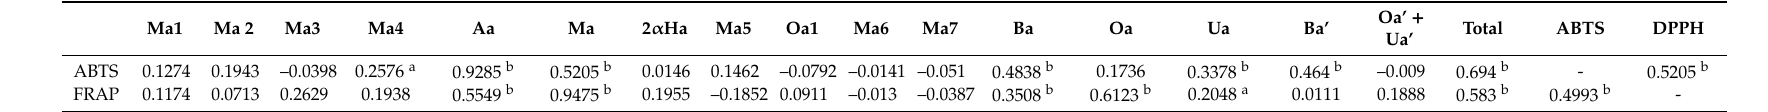
a Significant at p < 0.05. b Significant at p <